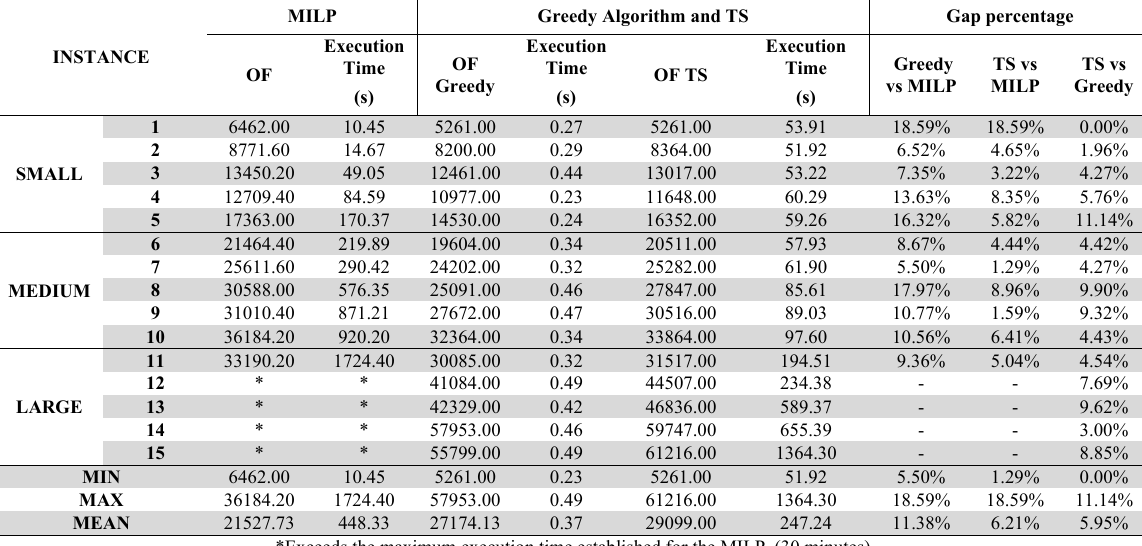
Results of the MILP, Greedy Algorithm and